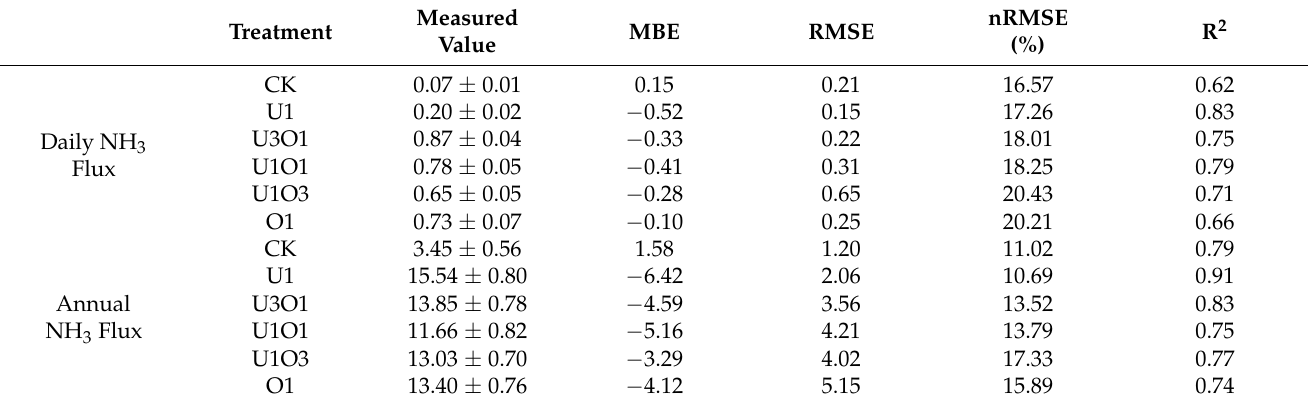
Table 5. Statistical evaluation between the modeled and measured daily NH 3 fluxes (kg N ha − 1 d − 1 ) and annual NH 3 fluxes (kg N ha − 1